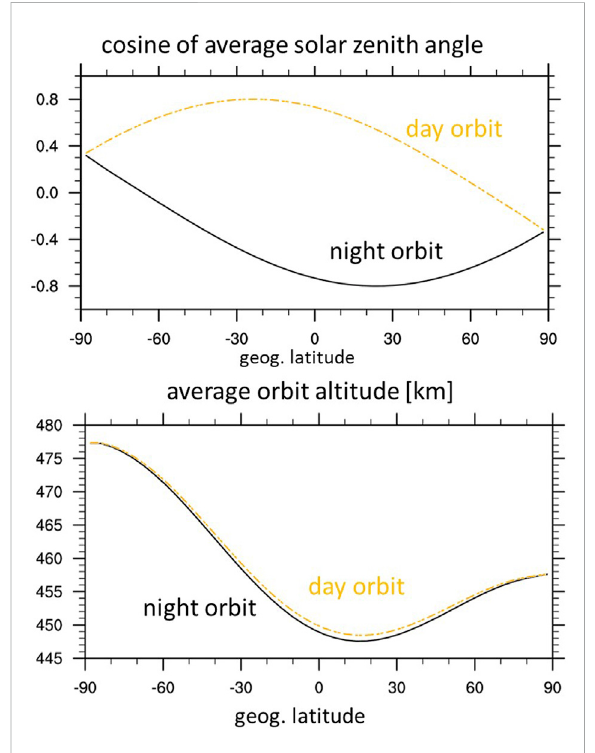
FIGURE 2 Cosine of average solar zenith angle (top) and average orbit altitude (bottom) (averaged between doy 30.0 – 35.0)